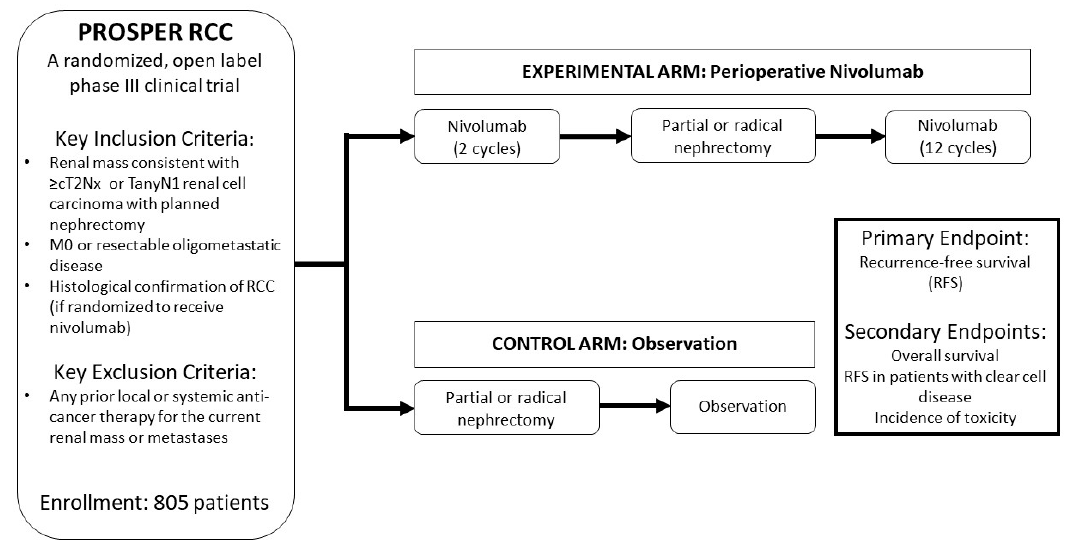
Figure 1. Schema for the phase-III ECOG-ACRIN PROSPER study.